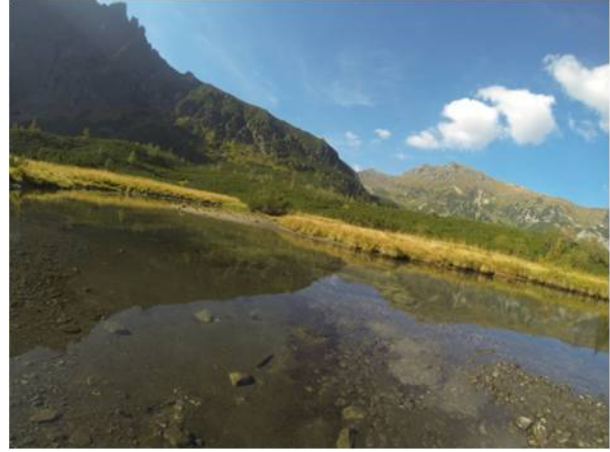
Figure 8. Photo of ˇCierne Javorové alpine lake where disruptive, reflected images are